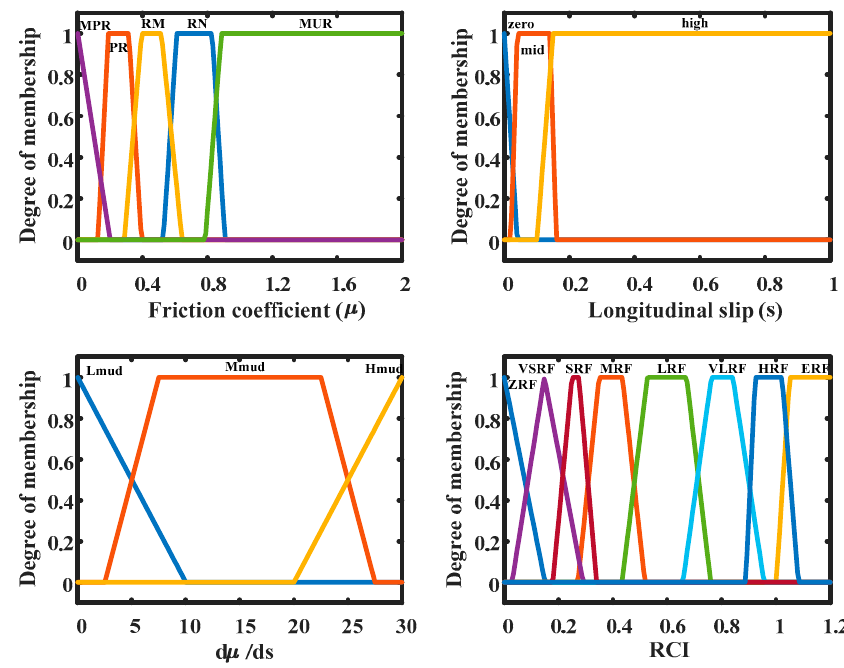
Figure 9. Membership functions for input and output variables of the road type detection block.